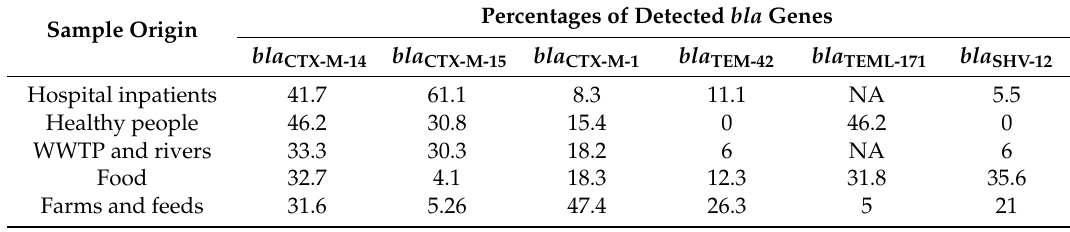
Table 1. Genotypic characteristics of extended-spectrum β -lactamase (ESBL)-producing E. coli according to their origin [5,28–30].